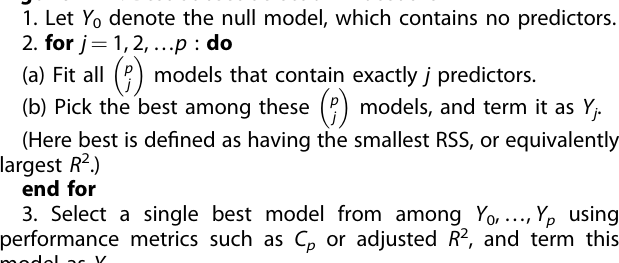
Algorithm 1 . Best Subset Selection Procedure 1. Let Y 0 denote the null model, which contains no predictors.